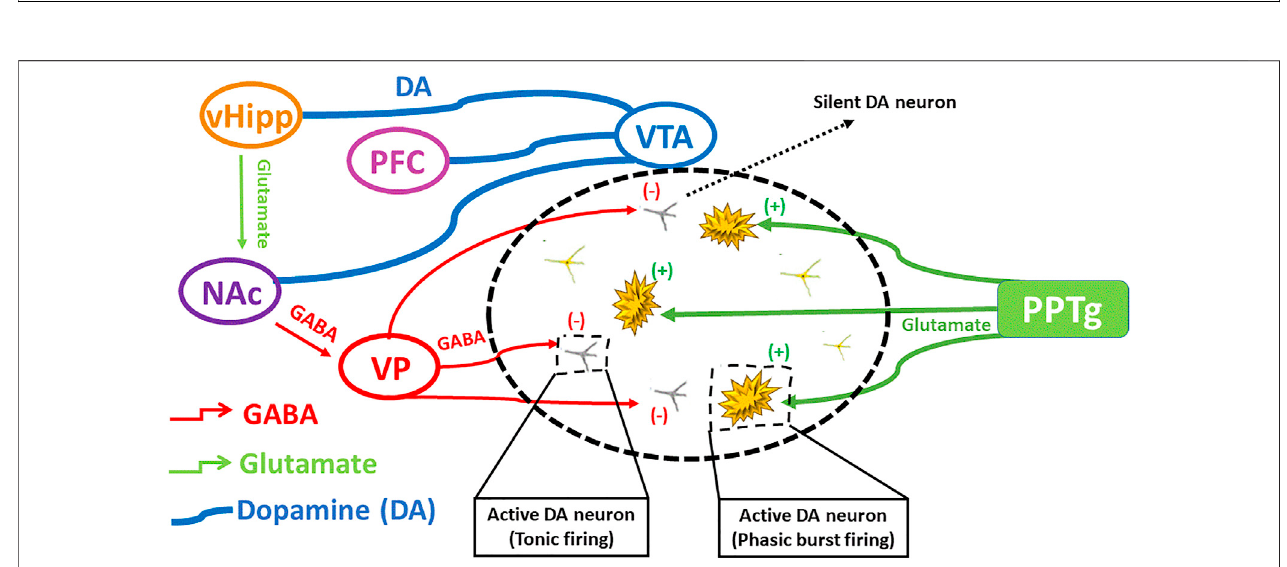
FIGURE2 | The interplay ofdifferentneuronalsignals involvedin schizophrenia. Ventral hippocampus regulates dopaminelevels byexcitatory projections towards ventral pallidum, that regulates GABAergic transmission producing silent DA neurons, in fl uencing on DA rapid burst fi ring and tonic fi ring. Modi fi ed from (Grace and Gomes